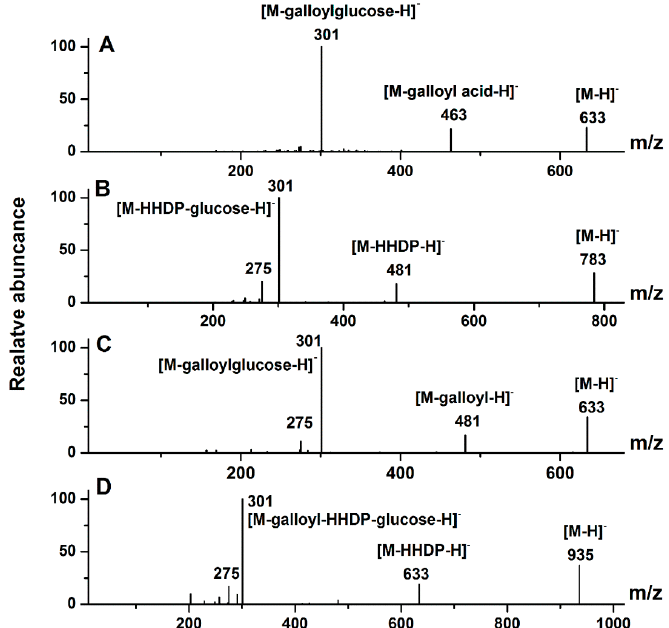
Figure 2. The MS/MS spectra of the standard of corilagin and some representative ellagitannins in D. indica : ( A ) corilagin; ( B ) peak 1; ( C ) peak 5; ( D ) peak 14. The peak numbers correspond to those used in Table 1.